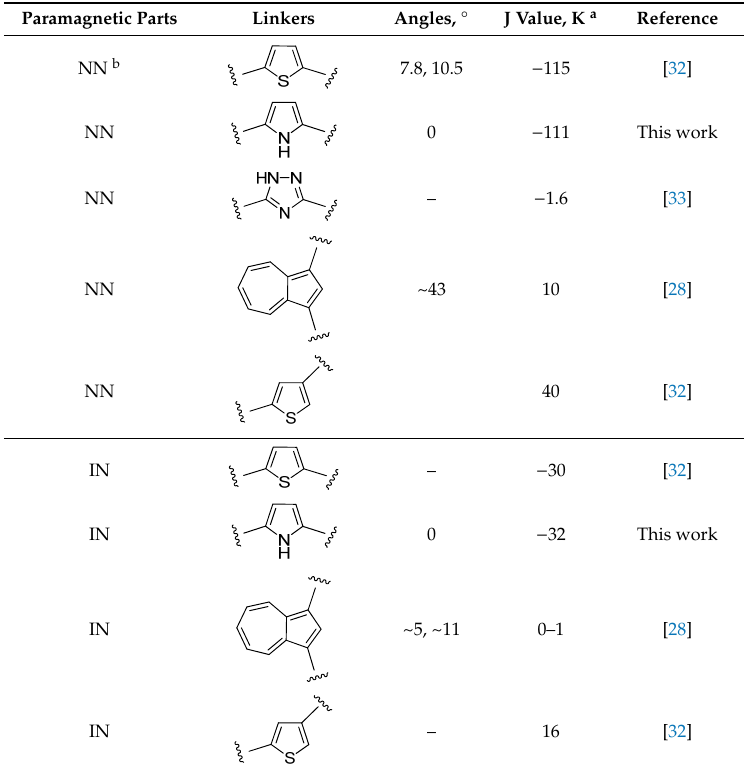
Table 2. Structures of nonalternant linkers, angles between planes of linkers and paramagnetic moieties, and experimental J values of intramolecular exchange interactions in diradicals.